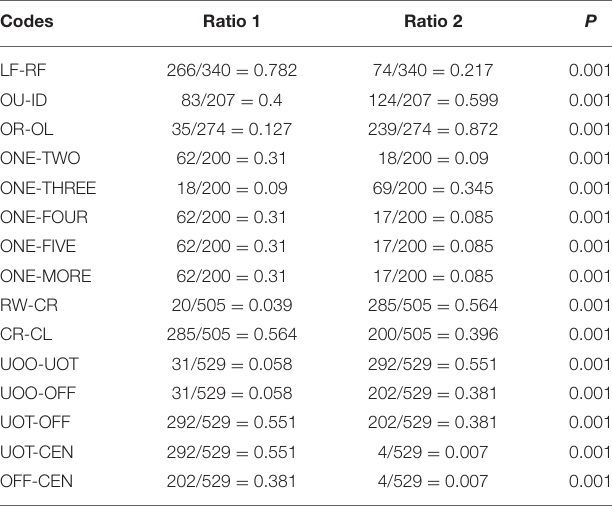
TABLE 3 | Comparison of statistically significant proportions between criteria from the OSMOS-soccer player